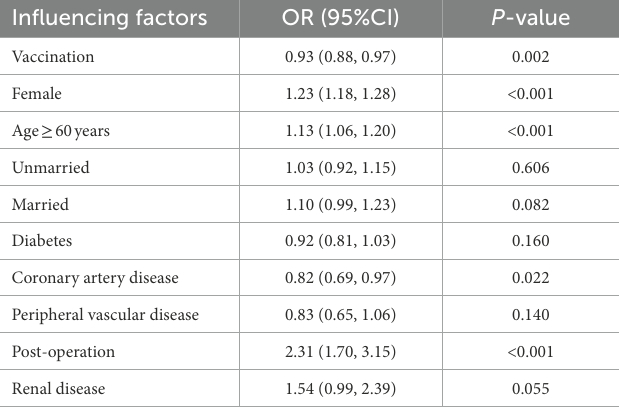
TABLE 4 Stepwise logistic regression analysis of the factors that influenced the presence of symptoms after the patients were infected with SARS- CoV-2.